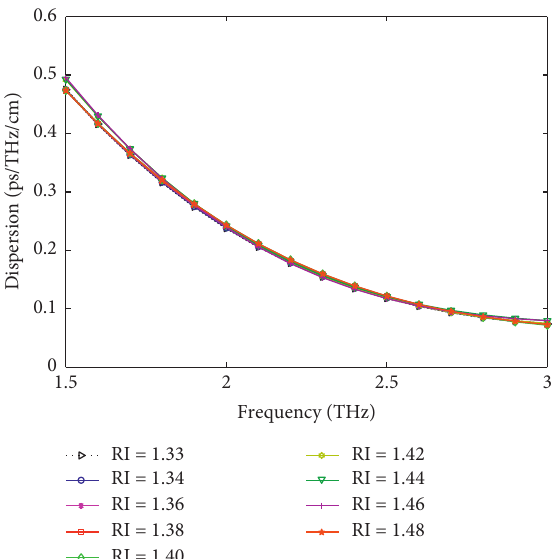
Figure 18: Representation of the dispersion of the proposed model in the THz band for different